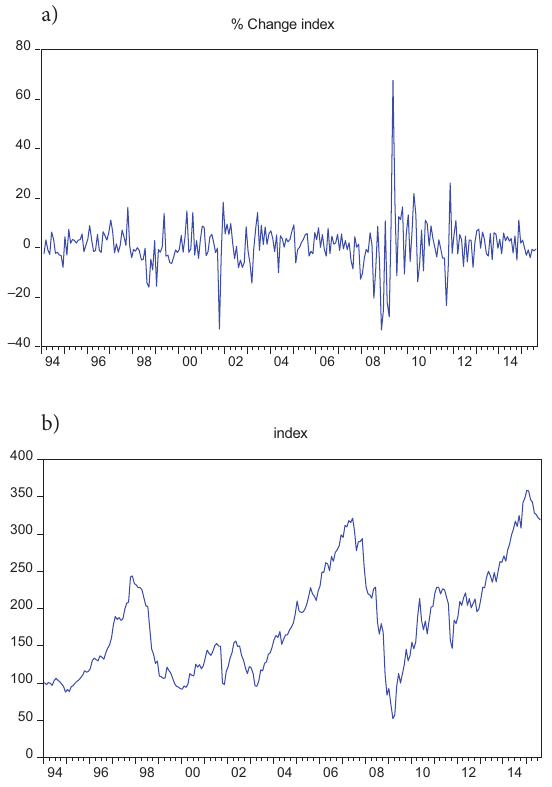
Figure 1. NAREIT lodging/resort Index: a) Time series plots of lodging/resort monthly returns; b) NAREIT lodging/resort subsector over the period from January 1994 to May 2016